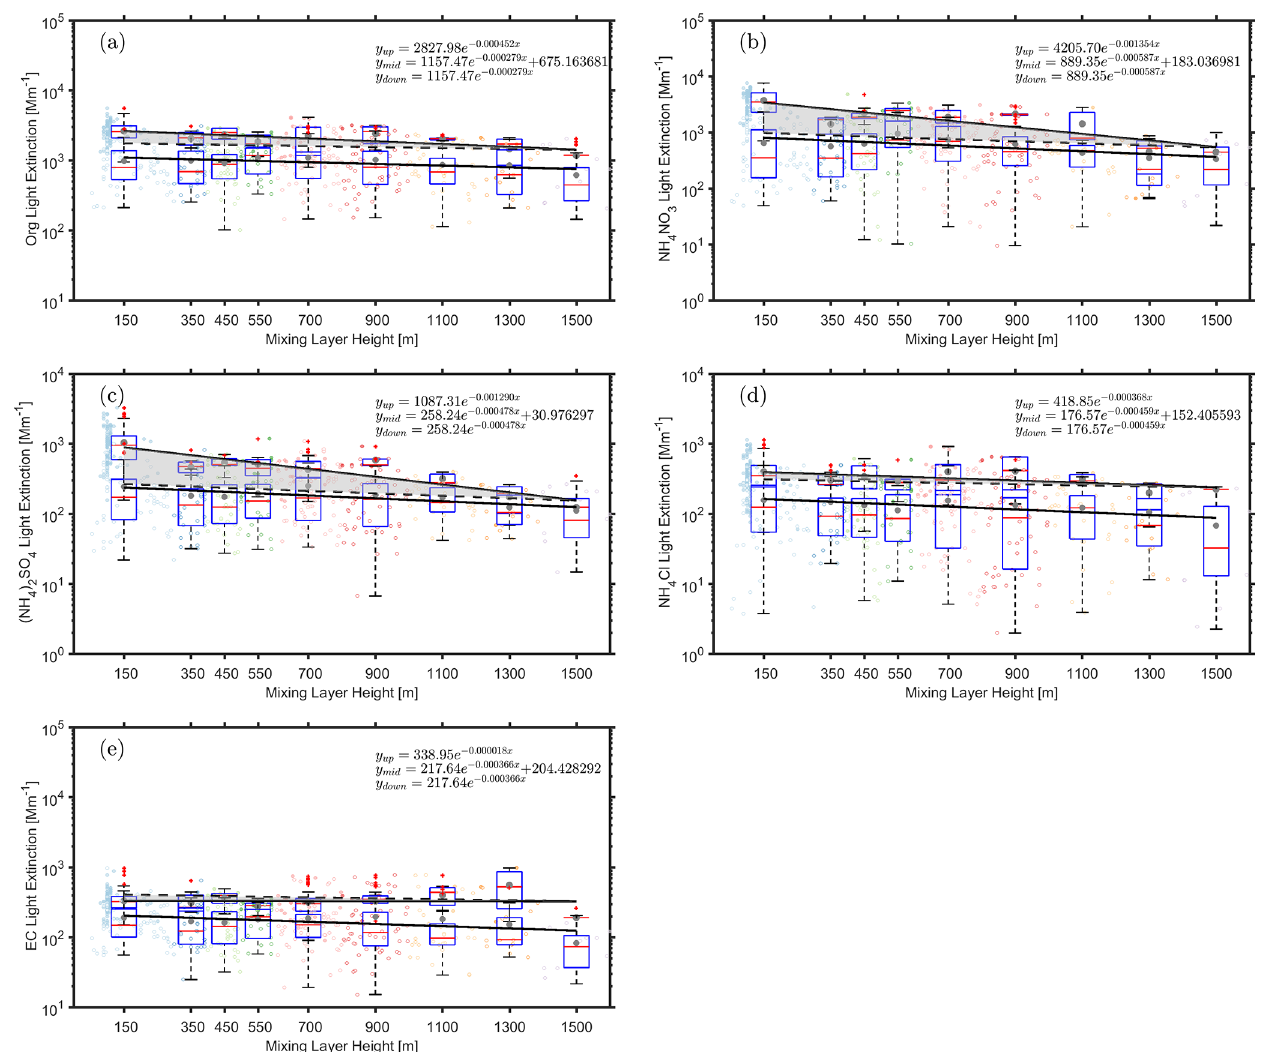
Figure 7. Observed dependency of the aerosol light extinction due to NH 4 NO 3 (a) , (NH 4 ) 2 SO 4 (b) , NH 4 Cl (c) , Org (d) , and EC (e) on the MLH during polluted and non-polluted conditions. The data related to the upper fitting line represent PM 2 . 5 concentrations larger than 75µgm − 3 , while the data related to the lower fitting line represent PM 2 . 5 concentrations less than 75µgm − 3 . Only daytime conditions determined by ceilometer from non-rainy periods (RH < 95%) are considered. The dark grey points and red lines in the boxes represent mean and median values, respectively. The shaded area between the upper solid and dashed line corresponds to an increased amount of PM 2 . 5 with a decreased MLH, assuming that PM 2 . 5 has the same variation pattern under highly polluted conditions as in less polluted